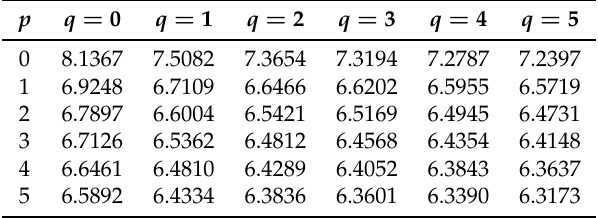
Table A5. Conditional entropies H ( p , q ) (bits/pixels), computed for various values of p and q , over “Scene-2”.